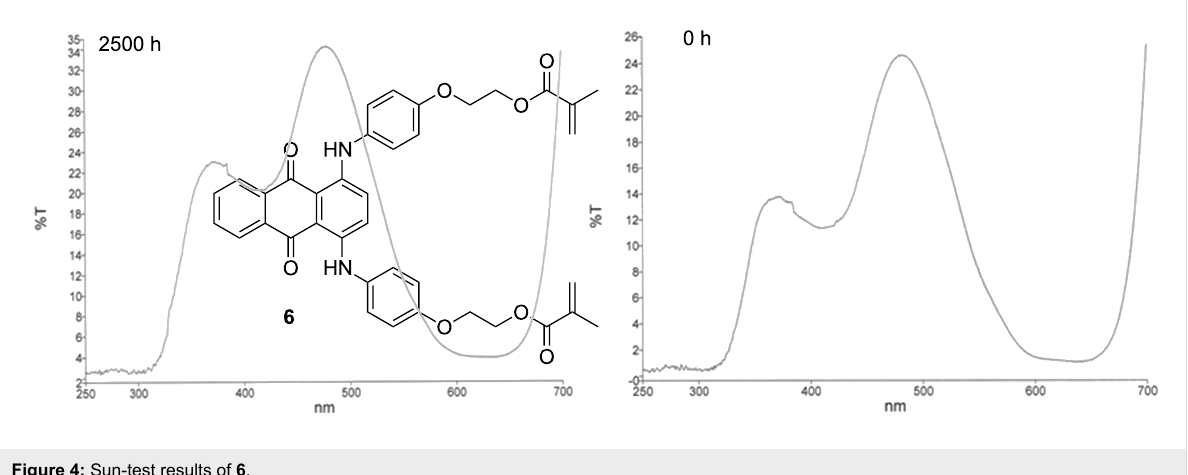
Figure 4: Sun-test results of 6 .